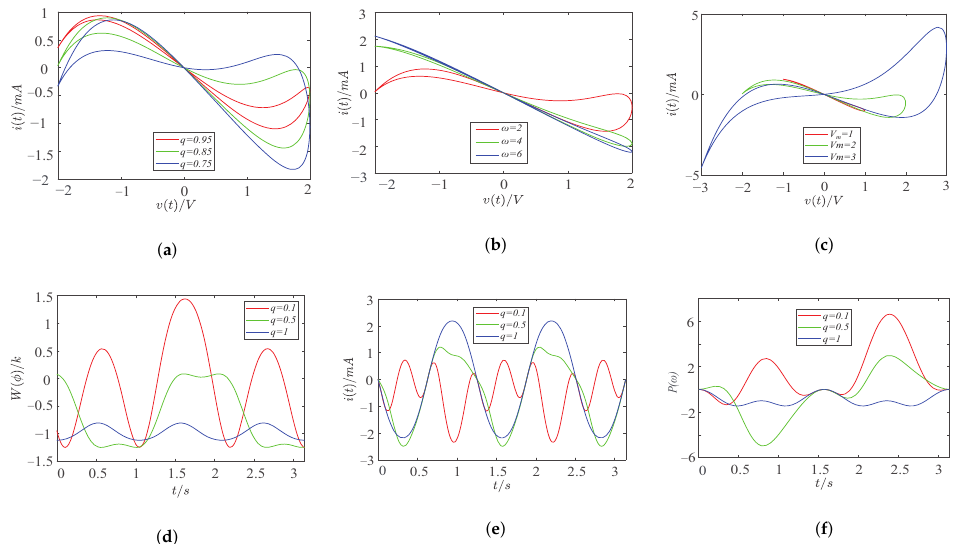
Figure 1. Characteristic comparison of fractional-order memristor. ( a ) Memristor hysteresis loops of different orders q ; ( b ) memristor hysteresis loops of different frequencies ω ; ( c ) memristor hys- teresis loops of different voltage amplitudes V m ; ( d ) time-domain diagram of the change in memris- tance W ( φ ) in different orders q ; ( e ) time-domain diagram of output current at different orders q ; ( f ) time-domain diagram of output power under different orders q ;